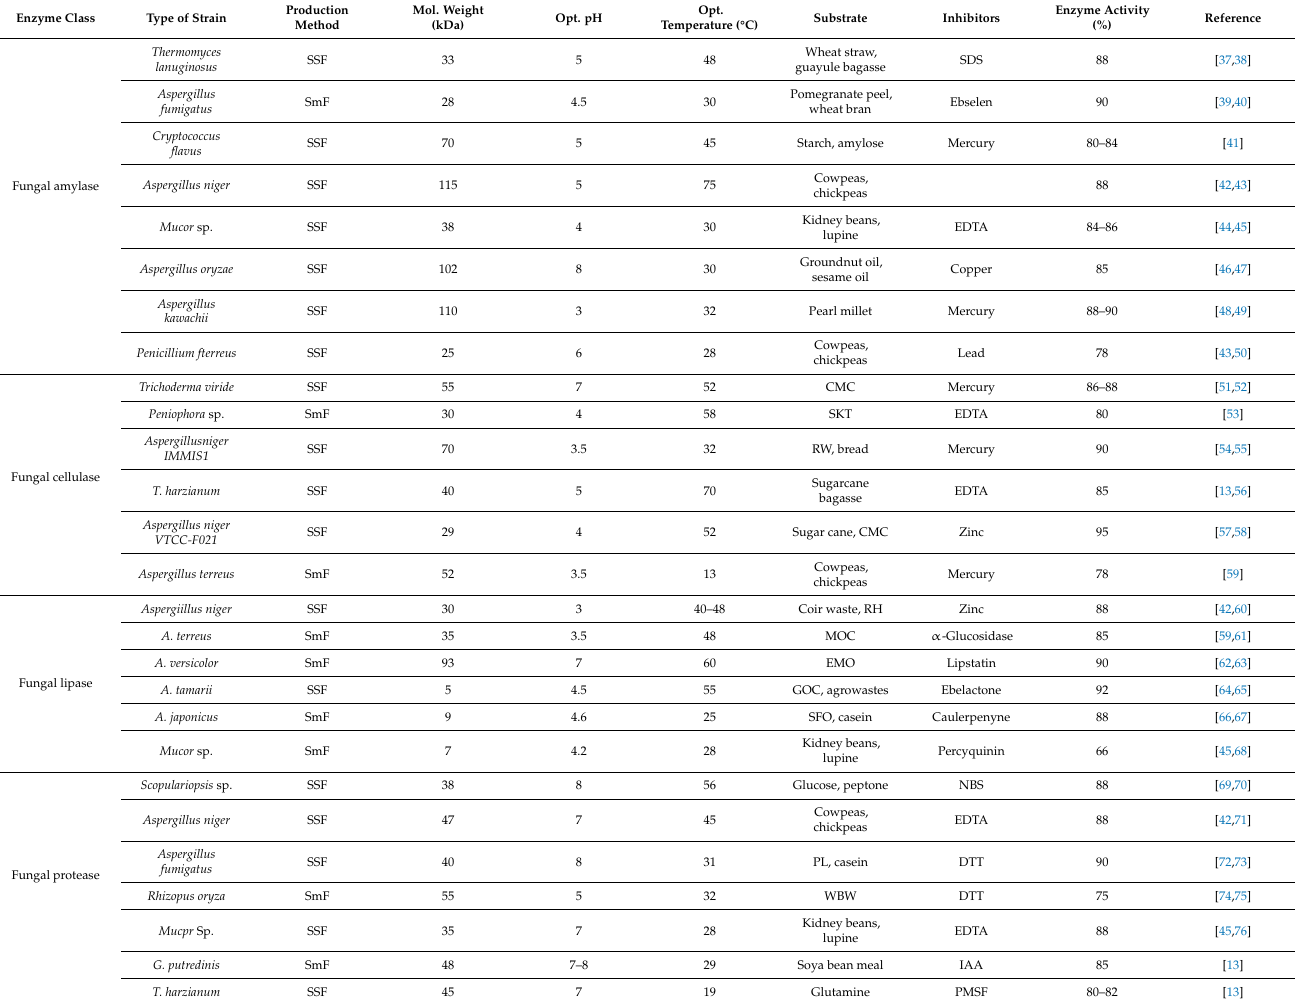
Table 1. The characteristics of different fungal